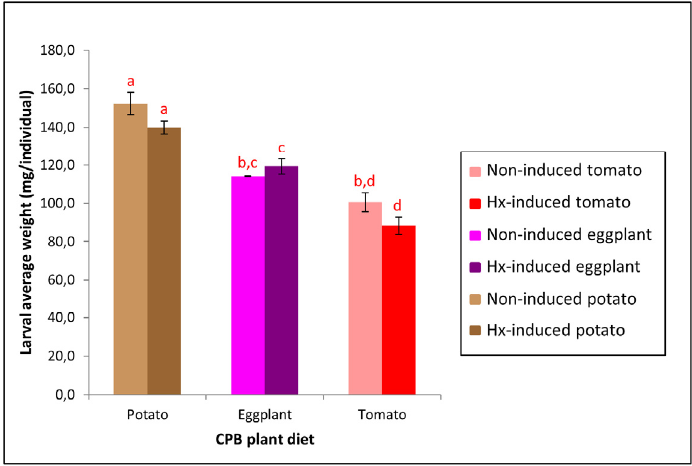
Figure 6. Mean larval weight of CPB larvae fed Hx-induced potato, eggplant or tomato versus CPB larvae fed non-induced plants. Error bars represent standard error of the mean of three biological replicates ( n = 3) of each sixteen CPB larvae. Means followed by the same letter were not significantly different (Student’s t -test, p > 0.05).